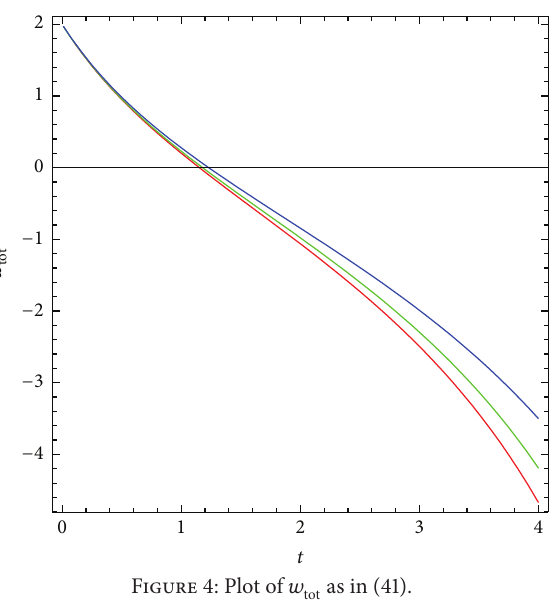
Figure 4: Plot of 𝑤 as in tot